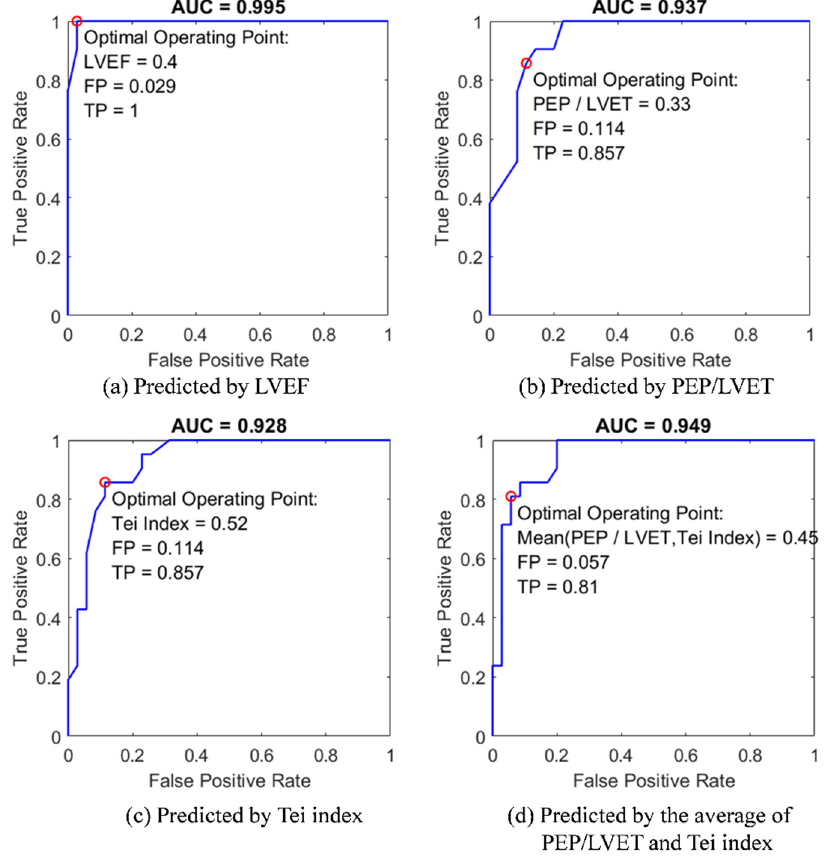
Figure 10. The comparison of ROC model analysis for the classification of patients with HFrEF by using four univariate predictors: ( a ) clinical LVEF assessment; ( b ) the PEP/LVET ratio; ( c ) Tei index; ( d ) the mean of PEP/LVET ration and Tei index.